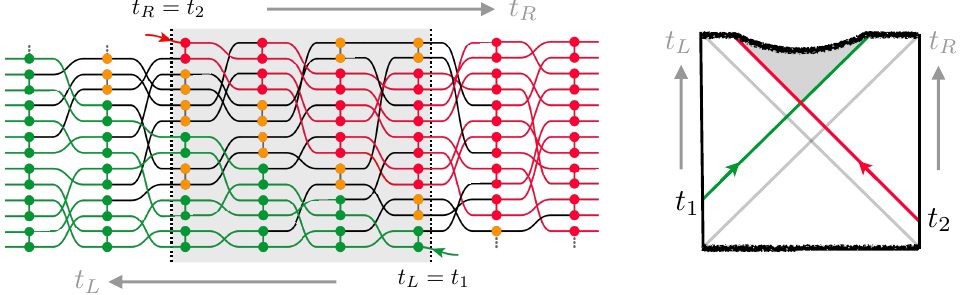
Figure 4 . Via ‘ER=EPR’ the quantum circuit model provides a qubit picture for the evolution of the thermofield double state. Time evolution on the left (right) boundary systems corresponds to increasing the depth of the circuit towards the left (right). The two signals sent into the wormhole correspond to two perturbations (‘infections’) spreading in opposite directions of the circuit. We quantify the amount of overlap of the two perturbations in the circuit (shaded grey in the left